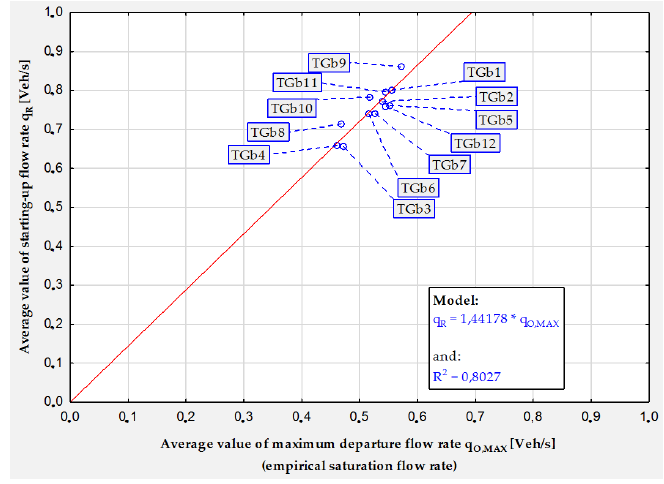
Figure 10. Results of the correlation analysis of the average values of the intensity of starting vehicles from the maximum queue as a function of the average values of the maximum intensity of the service.